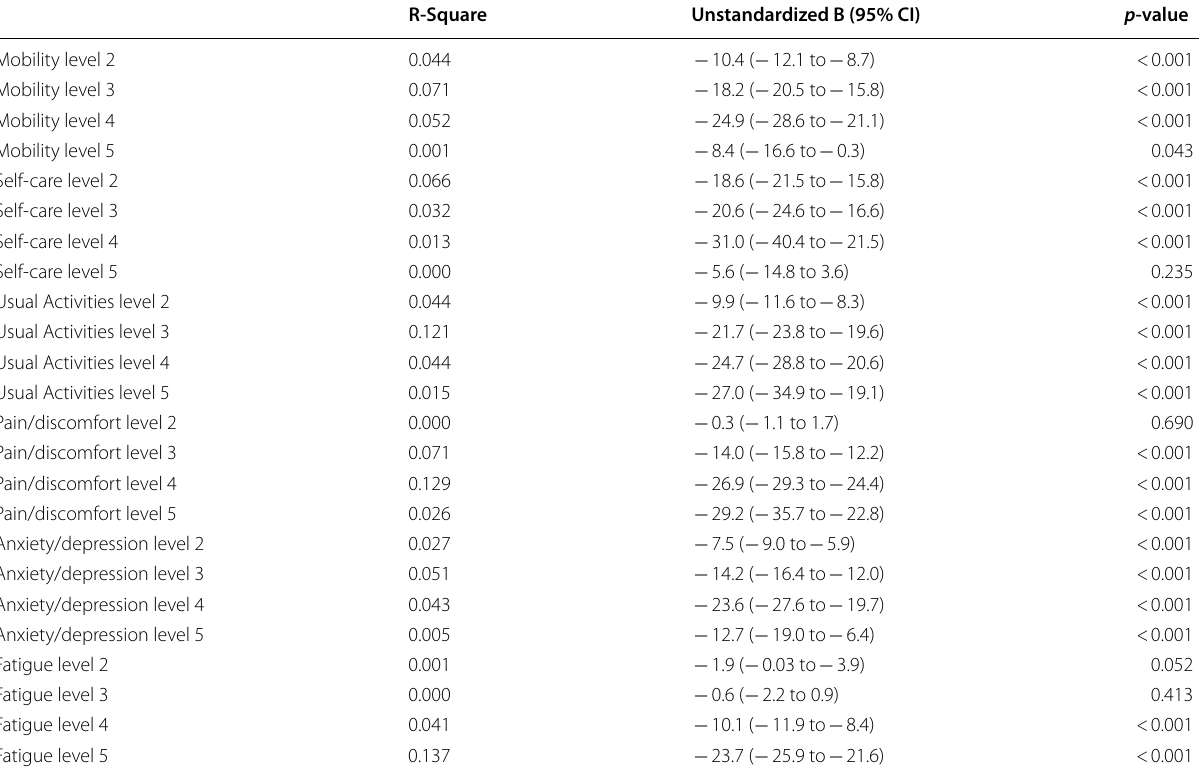
Table 6 Univariate analyses of the EQ VAS explained by the EQ-5D-5L and extra fatigue item R‑Square Unstandardized B (95%